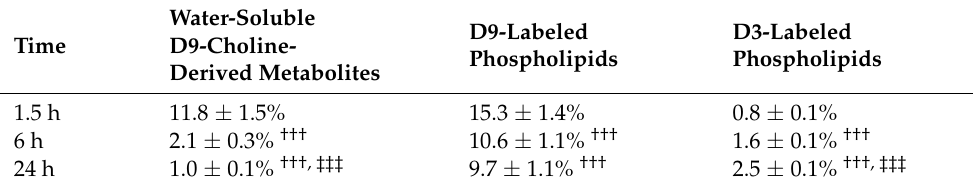
Table 2. Fractions of D9-Choline Metabolites of the Total Administered D9-Choline as Sum of All Analyzed